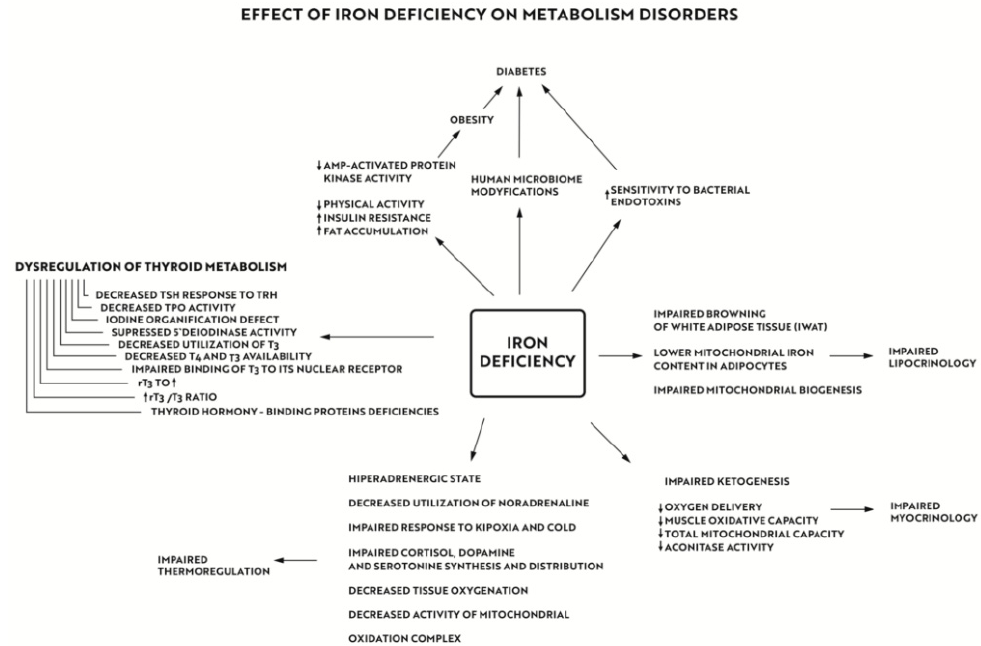
Figure 5. The effect of iron deficiency on metabolism disorders. Iron plays an extremely important role in the cross-talk between lipocrinology, glucocrinology and myocrinology, with thyroid hormones acting as a non-passive bystander and it's effect on thermoregulation.